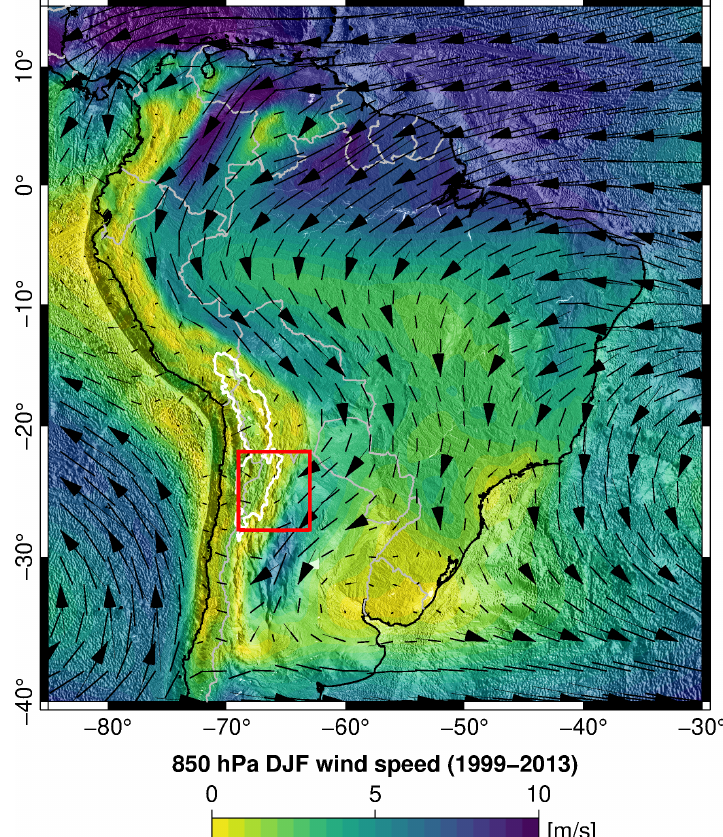
Figure 1. The 850-hPa austral summer months (DJF) mean wind speed (1999–2013) based on ERA-interim reanalysis data. The SALLJ with high wind speed is shown east of the central Andes. The study area is indicated by the red box and wind direction is indicated by black arrows (size is proportinal to velocity). The SALLJ is often associated with strong convection and abundant rainfall in the estern Andes. White line outlines the central Andean